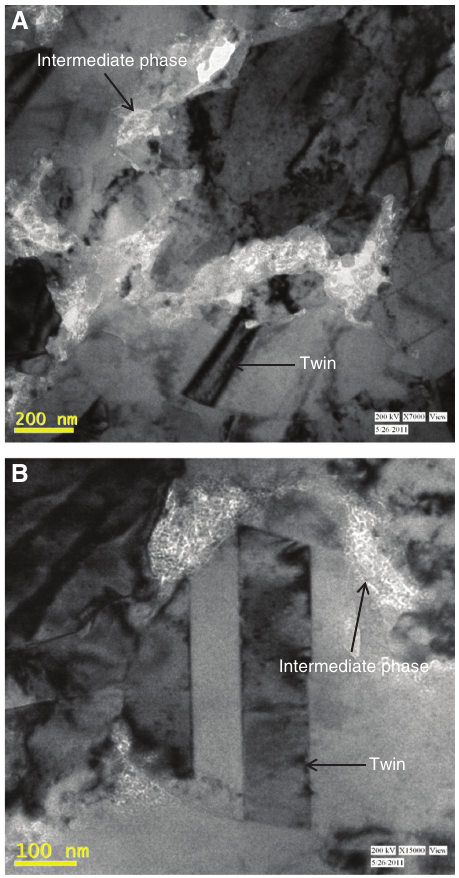
O nanocomposite 2 3